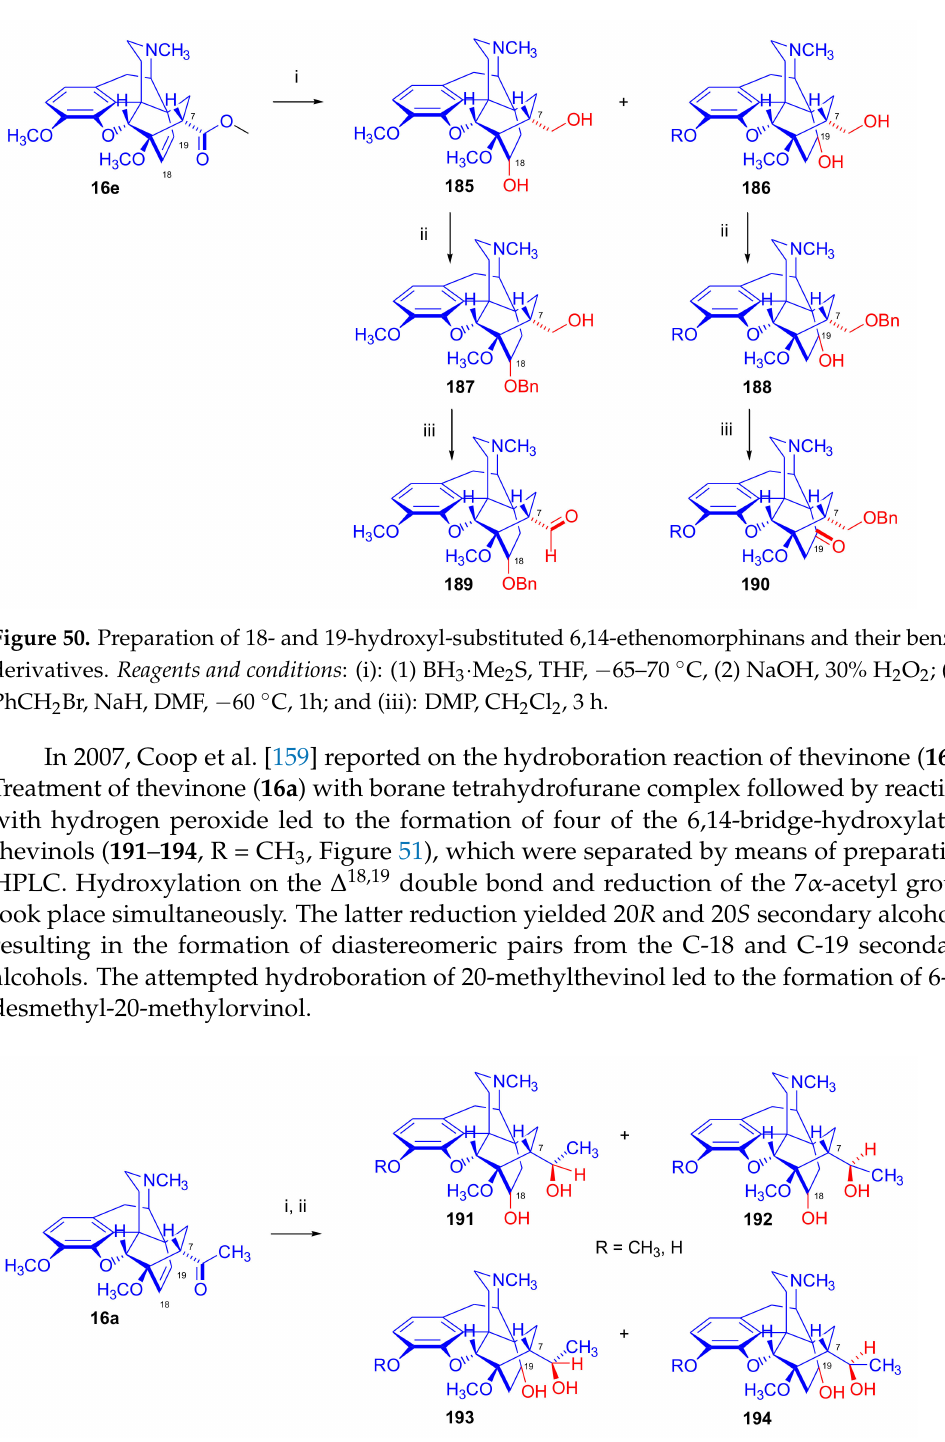
Figure 51. Hydroboration of thevinone. Reagents and conditions : (i): (1) BH 3 · Me 2 S, THF, − 65–70 ◦ C, (2) NaOH, 30% H 2 O 2